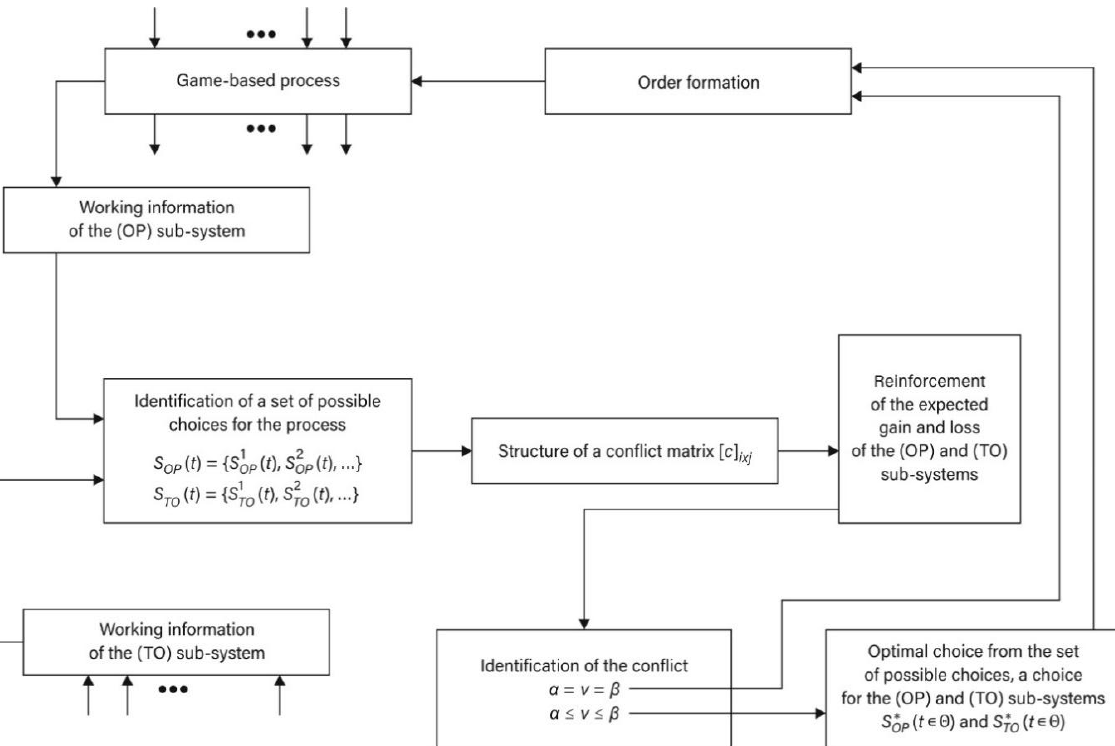
Figure 4. Model of a game-based process as a logistics game (LG) in the game-based system (GS) for the relation of the (OP) and (TO) during the time period ( t ∈ Θ ) : adapted from